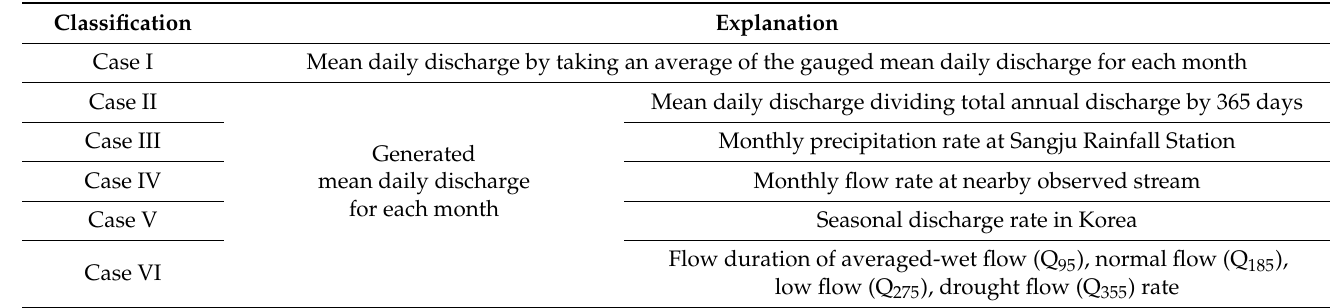
Table 2. Six scenarios of daily mean flow discharge for each